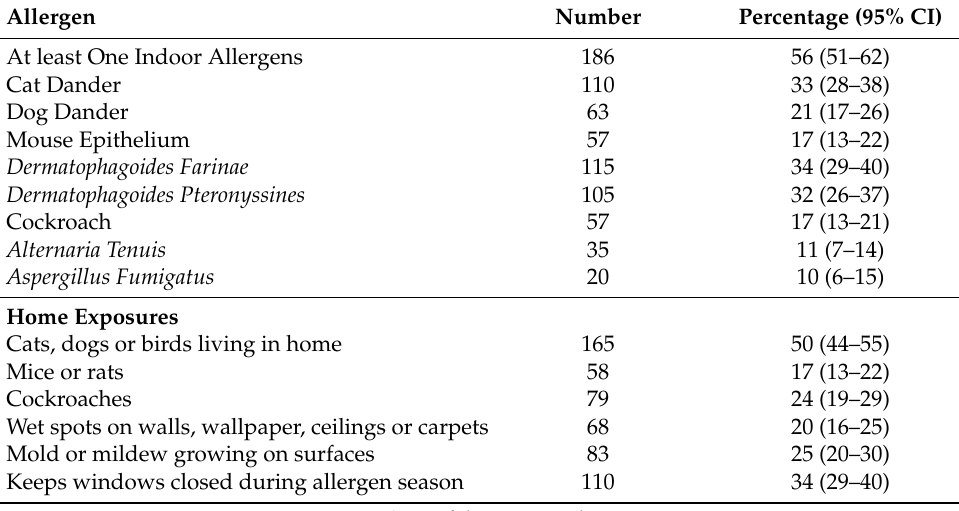
Table 2. Sensitization and exposure to indoor allergens among World Trade Center rescue and recovery workers with